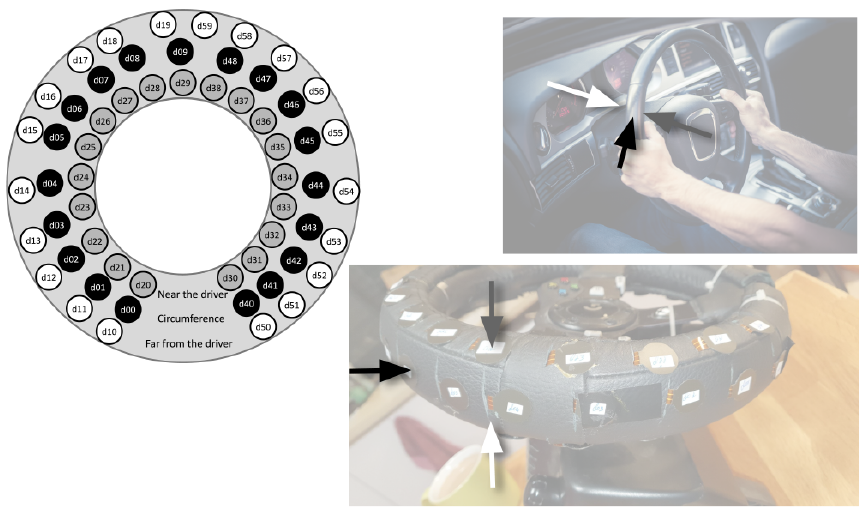
Figure 3. The steering wheel was embedded with 60 FSR sensors, which were grouped on three surfaces: close to the driver (grey circles in the illustration), on the circumference (black circles in the illustration), and on the surface far from the driver (white circles in the illustration).